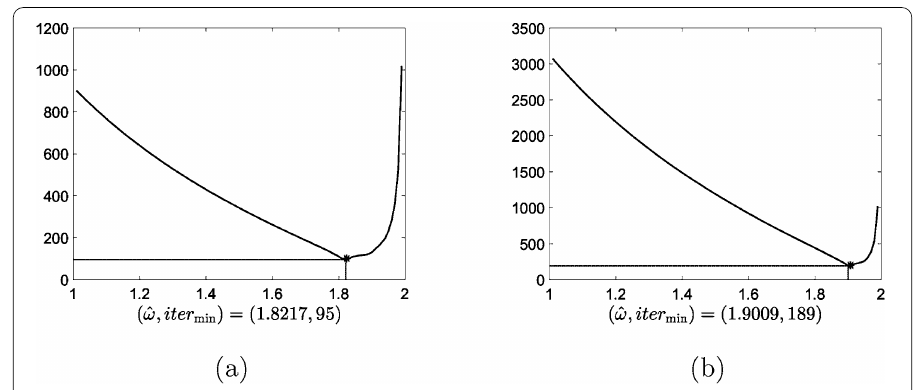
Figure 12 The relaxation parameter ω (horizontal axis) vs. the number of iterations (vertical axis) for solving the linear obstacle problem with ϕ = ϕ 3 by the obstacle SOR. (a) when h = 1/64 and (b) when h =